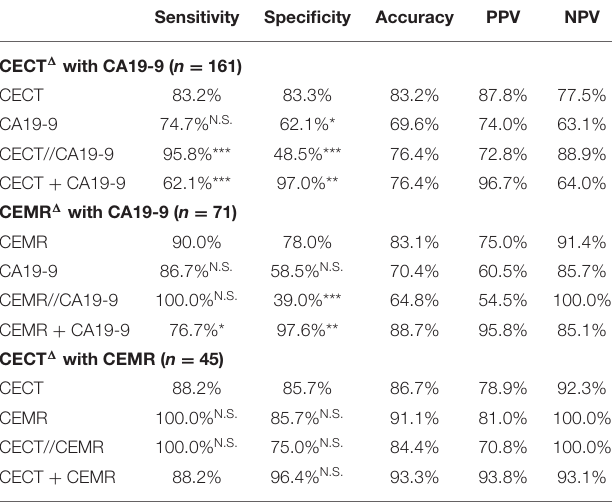
TABLE 6 | Diagnostic efficiencies of other combinations. Sensitivity Specificity